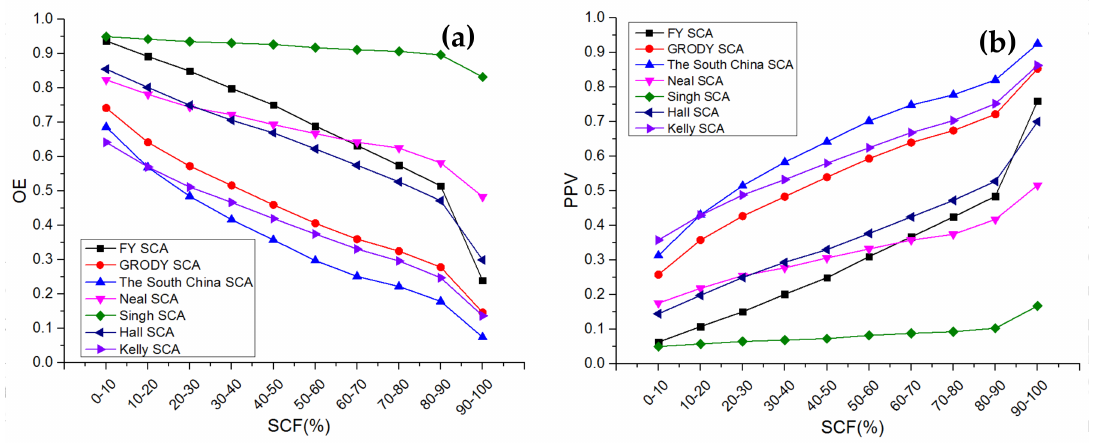
Figure 7. OE ( a ) and PPV ( b ) of the PMW SCA mapping algorithms associated with different